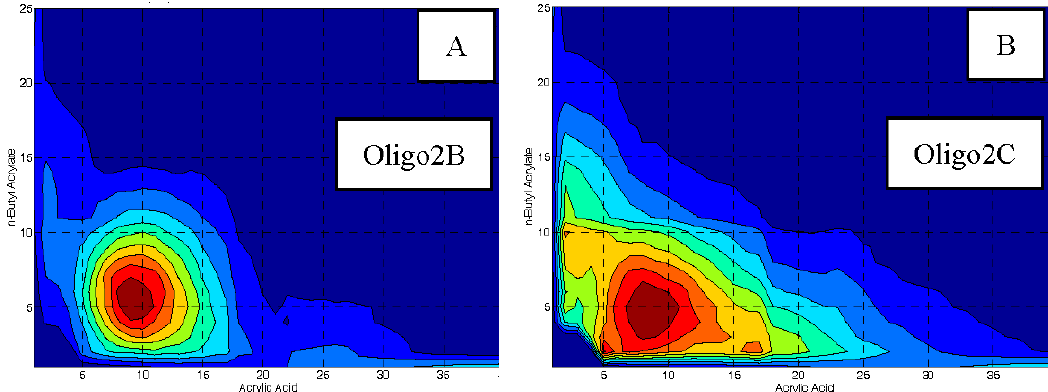
Figure 5. Composition of Oligo 2 synthesized in isopropanol ( A ) and ethanol ( B ) from MALDI-ToF MS analysis showing the number of acrylic acid units (x-axis) and butyl acrylate units (y-axis).